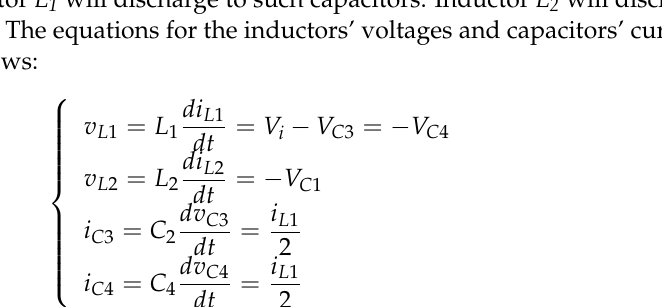
Figure 3. Operating modes of the DC/DC converter: ( a ) Mode 1: S W → ON , ( b ) Mode 2: S W → OFF .